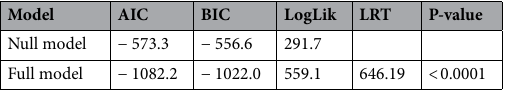
Table 3. Linear mixed model comparison.